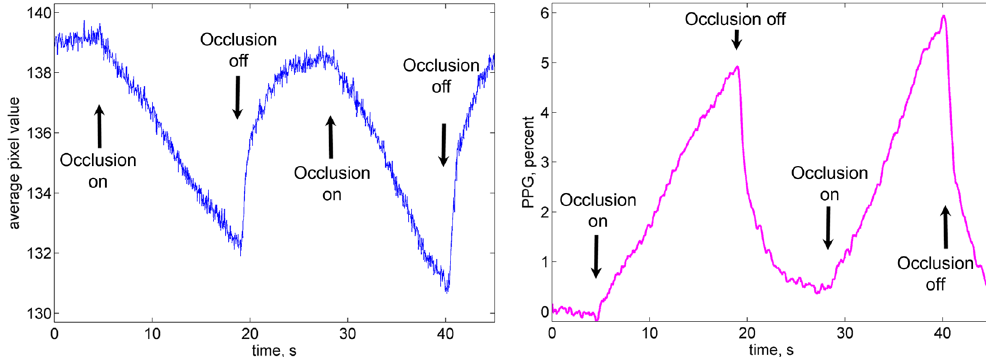
Figure 1. Typical PPG waveform. ( a ) Evolution of the mean pixel value in an arbitrary chosen ROI in the forearm during double venous occlusion. ( b ) The respective PPG waveform after its normalization to the mean pixel value measured before the first occlusion, deduction of the unity, and